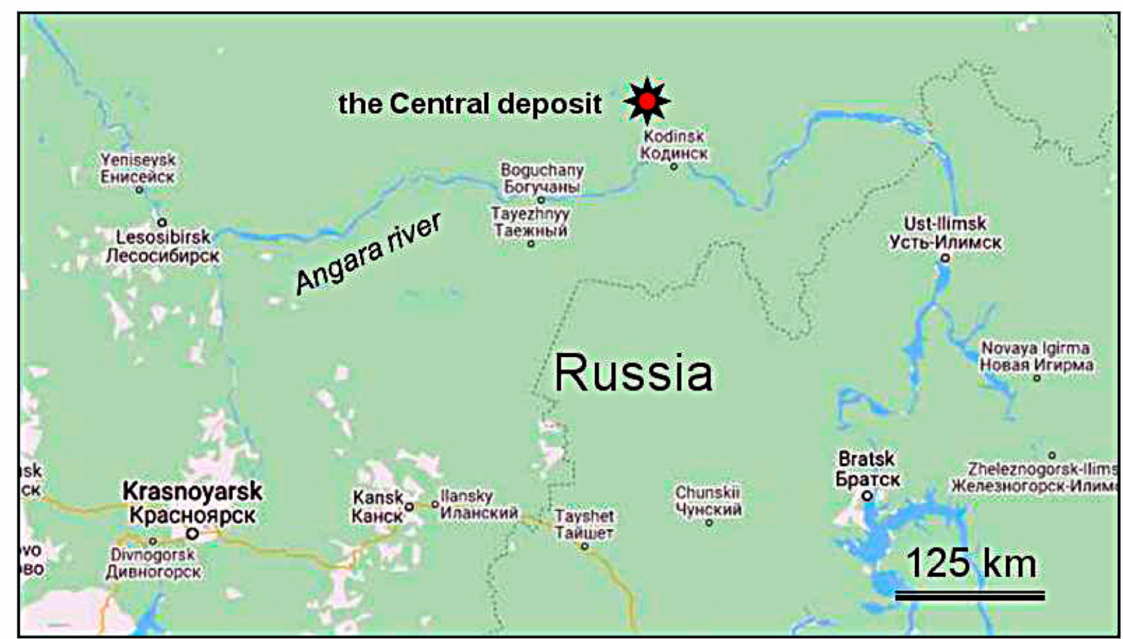
Figure 1. The location of the Central Deposit